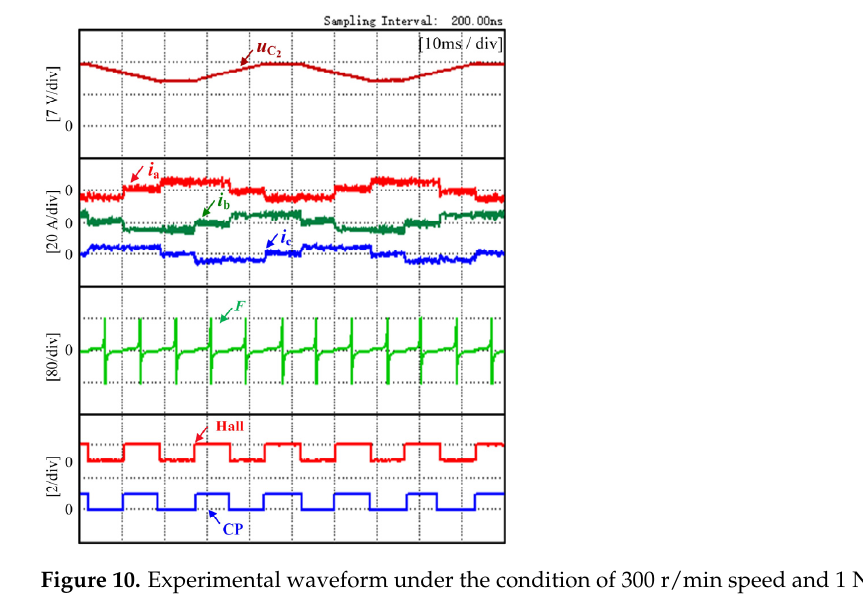
Figure 9. Line-to-line PM flux linkage and Hall signal waveform at 300 r/min.